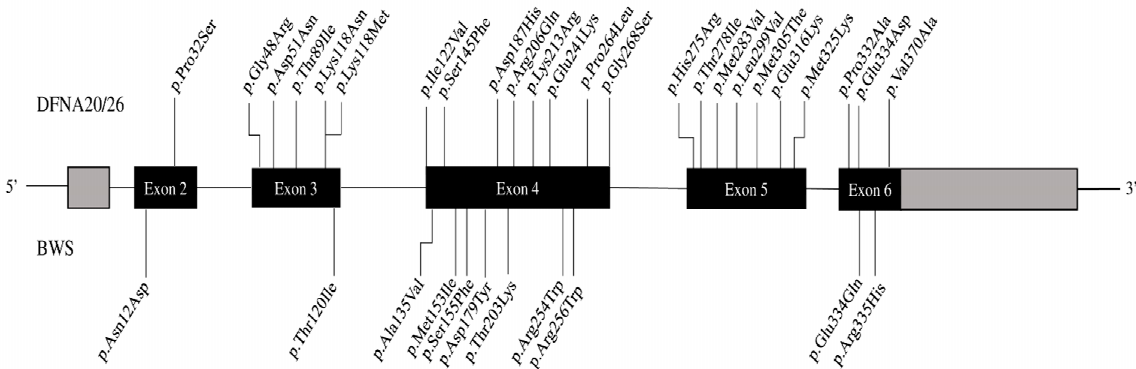
Figure 2. ACTG1 variants. Schematic representation of the full-length ACTG1 gene showing the different exons and locations of the reported variants. Variants associated with DFNA20/26 are indicated above the gene and those associated with BWS2 are below the gene.